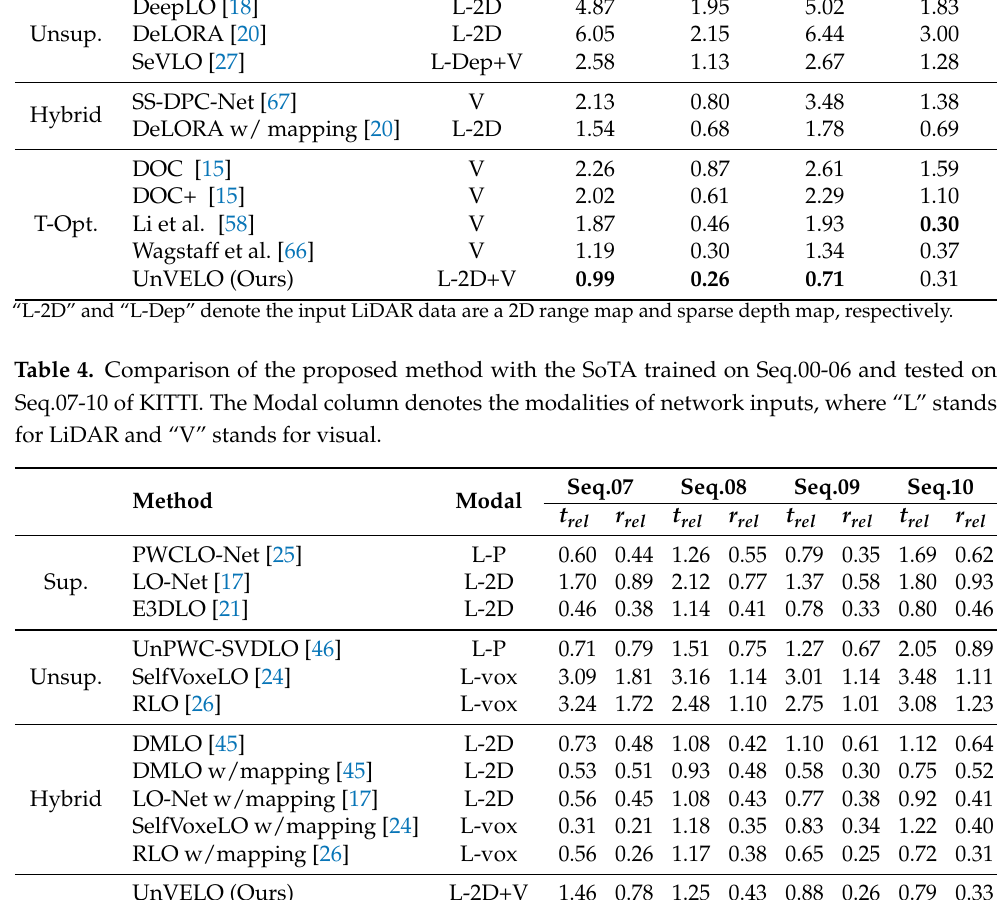
Table 3. Comparison of the proposed method with the SoTA trained on Seq.00-08 and tested on Seq.09-10 of KITTI. The Modal column denotes the modalities of network inputs, where “L” stands for LiDAR and “V” stands for visual. The best results are bold. Seq.09 Seq.10 Modal t rel r rel t rel r rel Unsup.